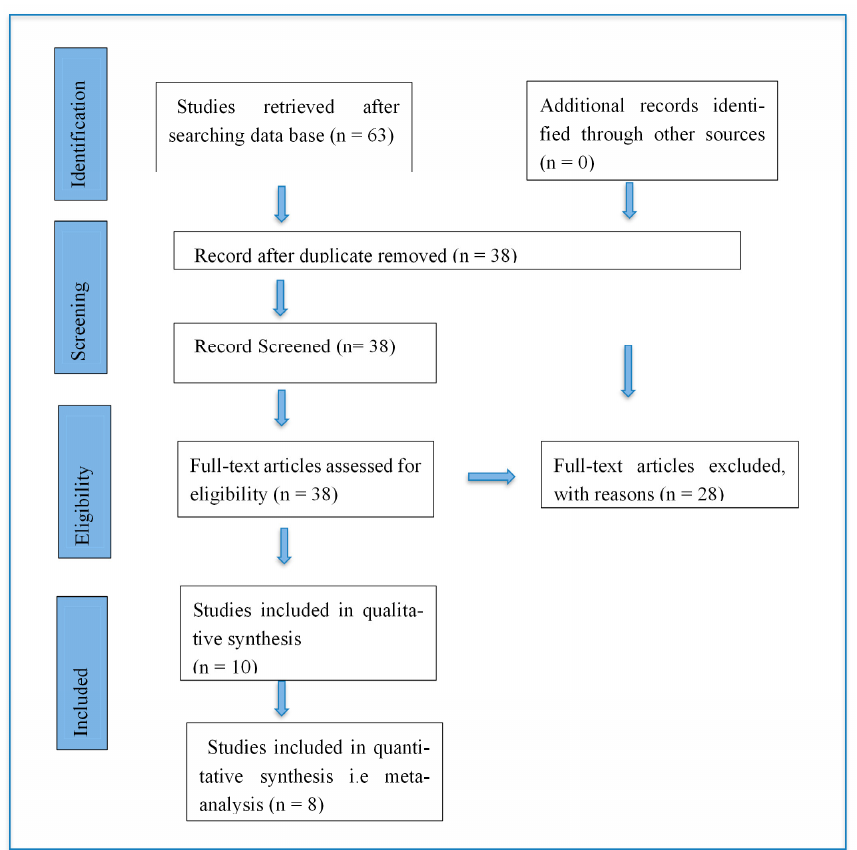
Figure 1. Schematic representation of the PRISMA flowchart for literature search performed in this study.